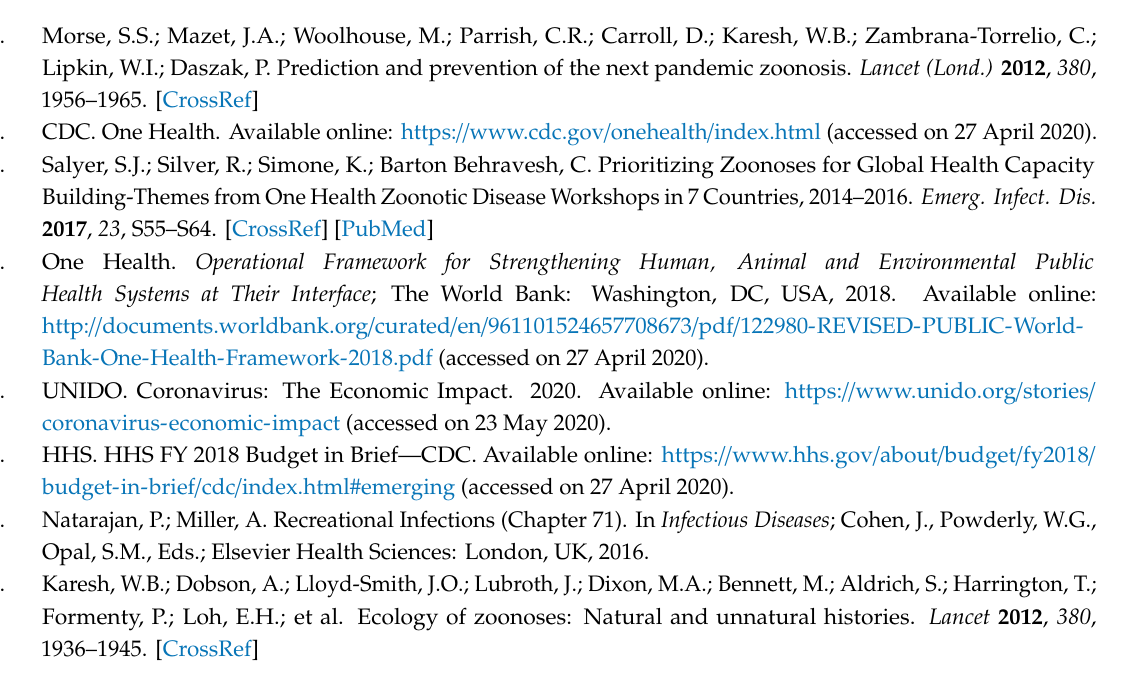
Table S1: Selected bacterial zoonoses, Table S2: Selected viral zoonoses, Table S3: Selected parasitic and other non-bacterial non-viral